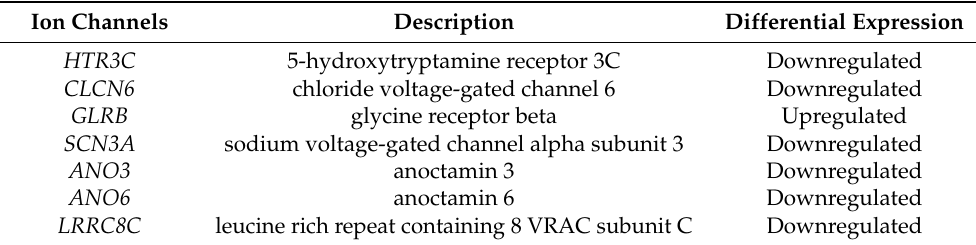
Table 2. A partial list of differentially expressed ion channels in HT state in breast